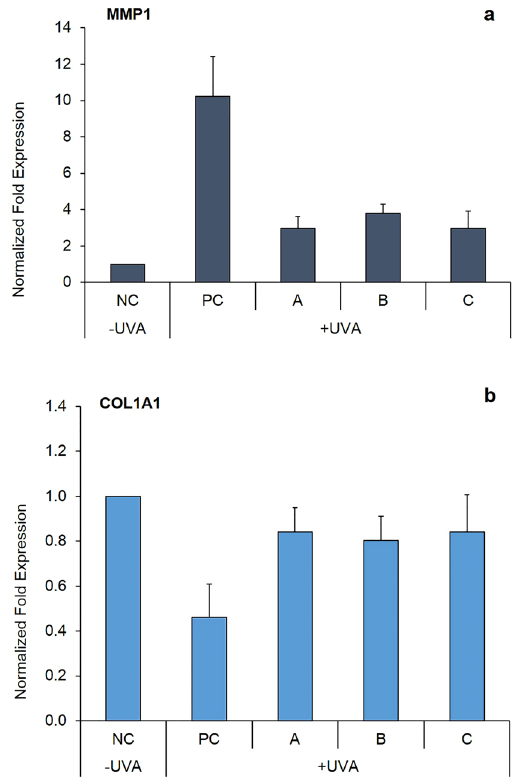
Figure 2. Gene expression analysis of MMP1 (panel a) and COL1A1 (panel b) in human dermal fibroblasts (HDF) exposed to UVA (366 kJ m − 2 ), assessed using qPCR 24 h post-irradiation. Data are reported as normalized fold expression using the 2 − ∆∆ Ct method. HDF were screened with sunscreens A (European sunscreen), B (USA sunscreen), C (eco-friendly sunscreen) or with no sunscreen (PC = positive control) and exposed to UVA. NC = negative control, unexposed HDF. Error bars represent standard error (n =